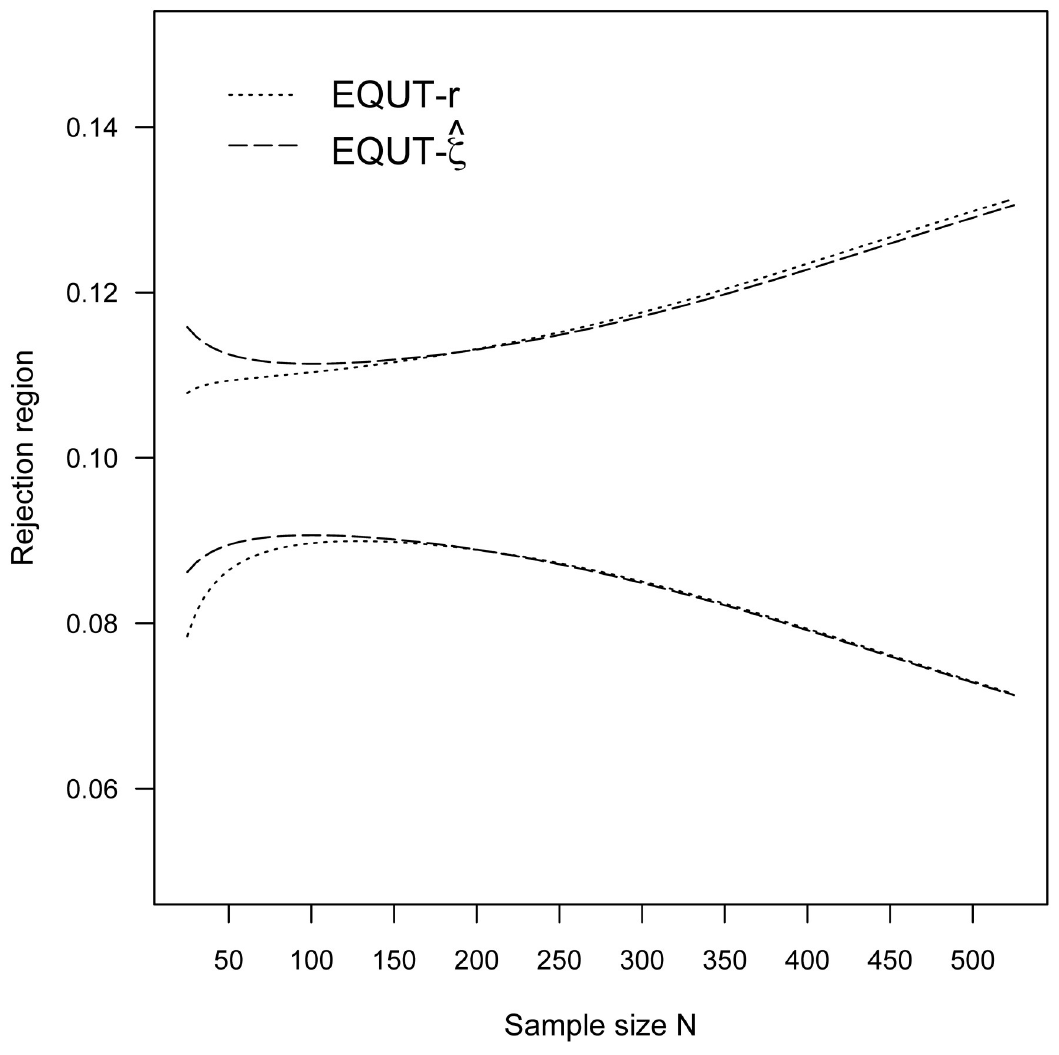
Fig 1. The rejection regions for ( ρ